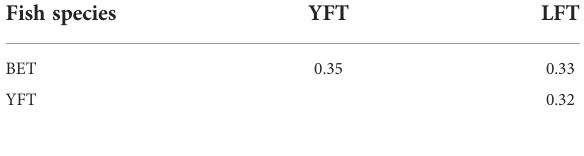
TABLE 3 Food overlap coef fi cient of three species of tuna: Thunnus obesus (BET), Thunnus albacores (YFT), and Thunnus alalunga